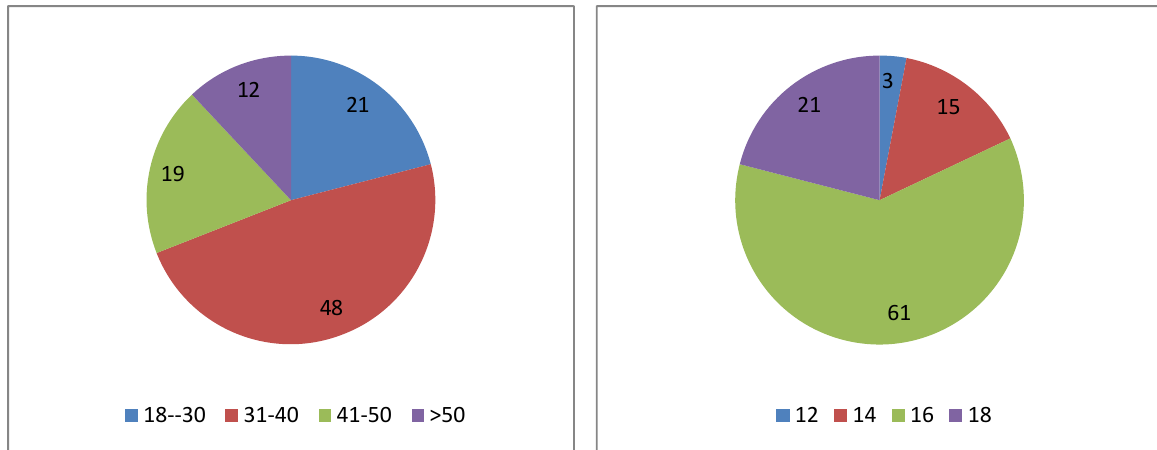
Fig. 1. Personal characteristics of the